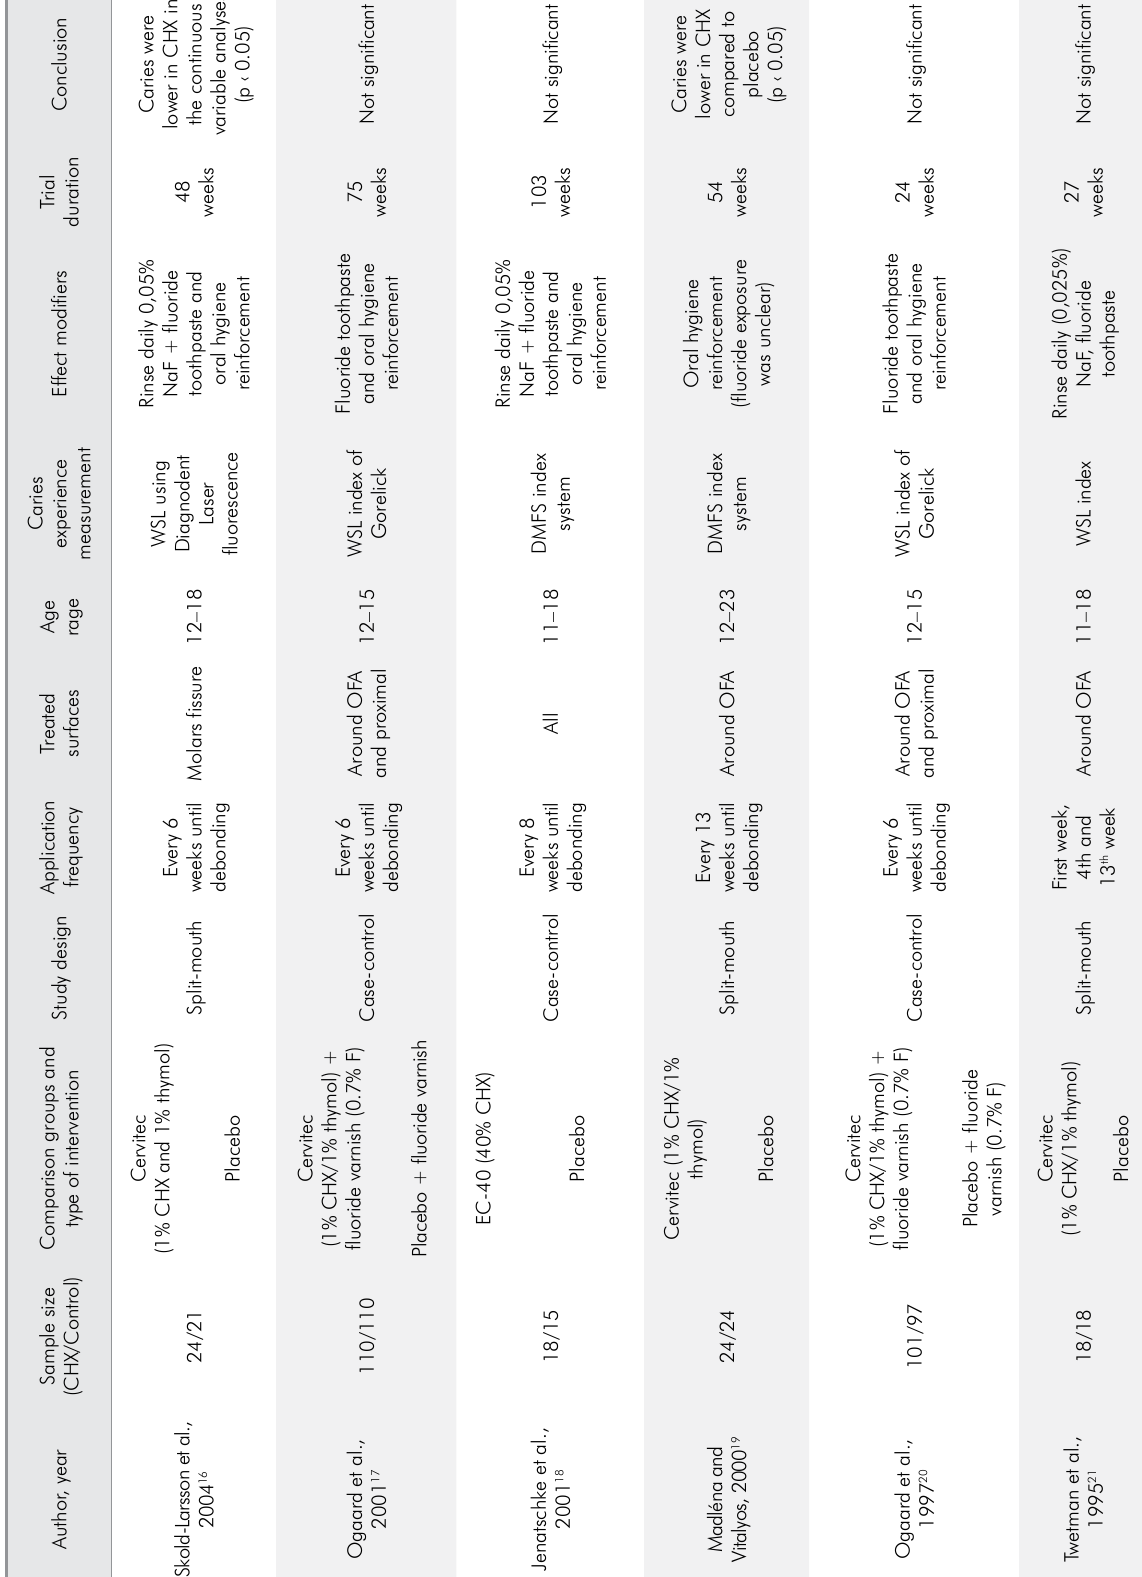
5 Braz. Oral Res.